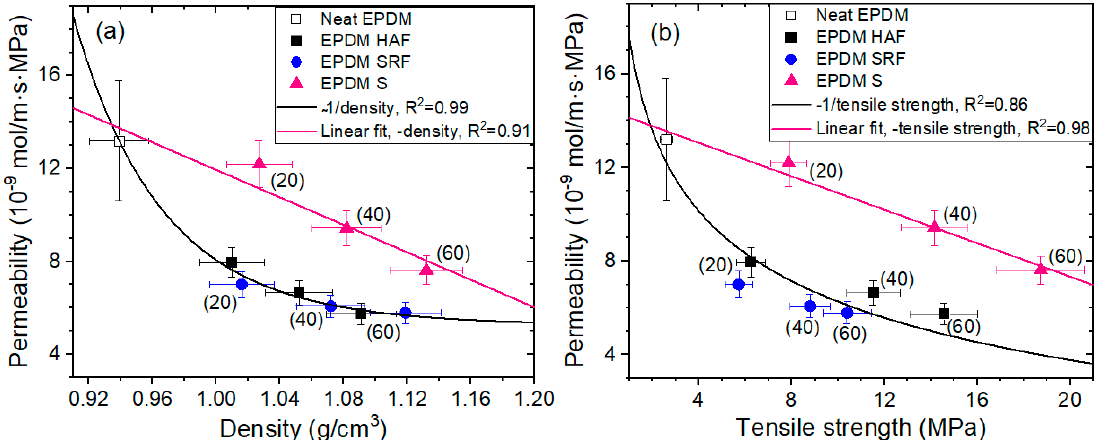
Figure 9. Correlations between permeability and ( a ) density and ( b ) tensile strength for neat EPDM and EPDM composites blended with CB/silica. The data for neat EPDM are included as pink and black curves for consistency with the fittings of the filler-blended EPDM composites. The value in parentheses indicates the phr of CB and silica. R 2 is squared correlation coefficients of fitting.